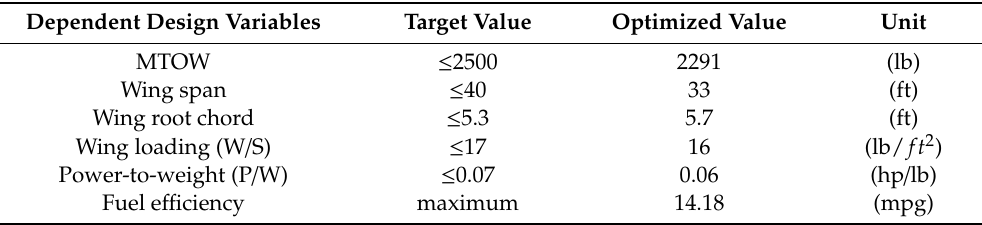
Table 9. Optimized dependent design variables.